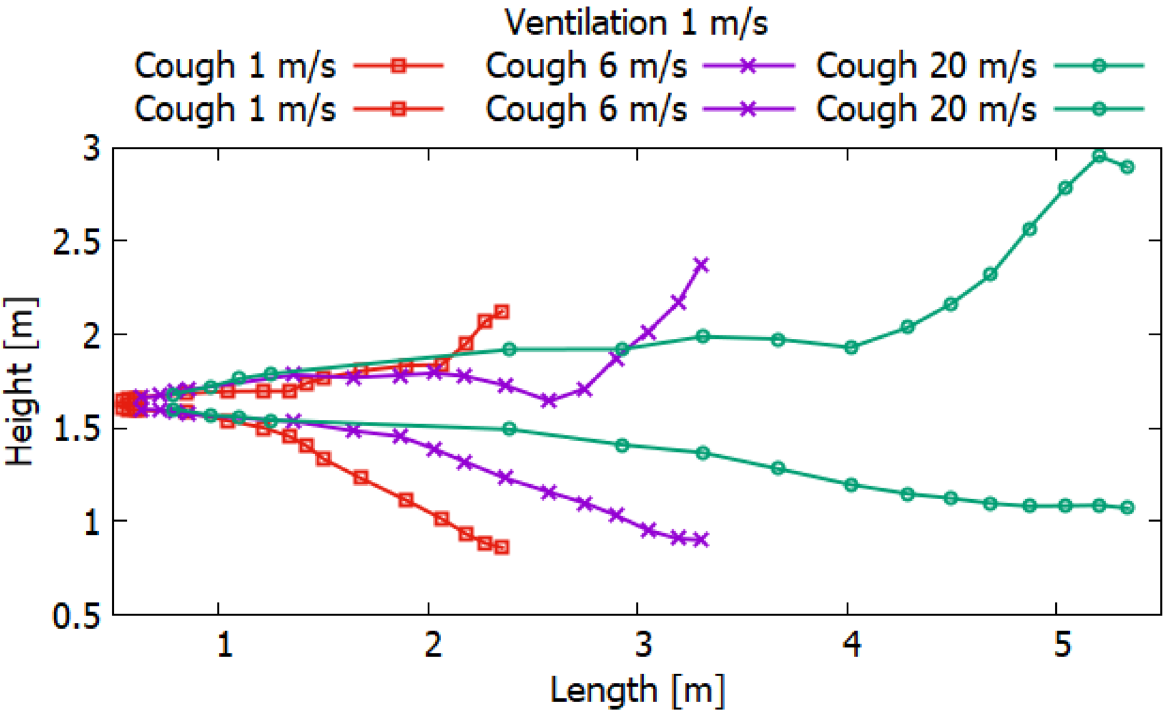
Figure 26. Particle propagation range for scenarios